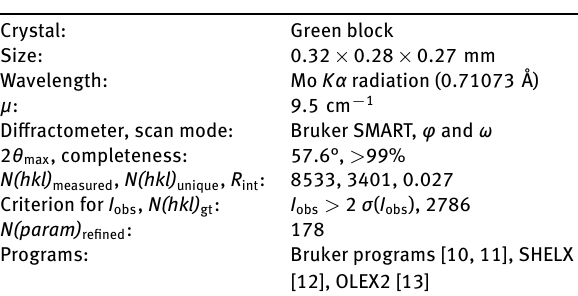
Table 1: Data collection and